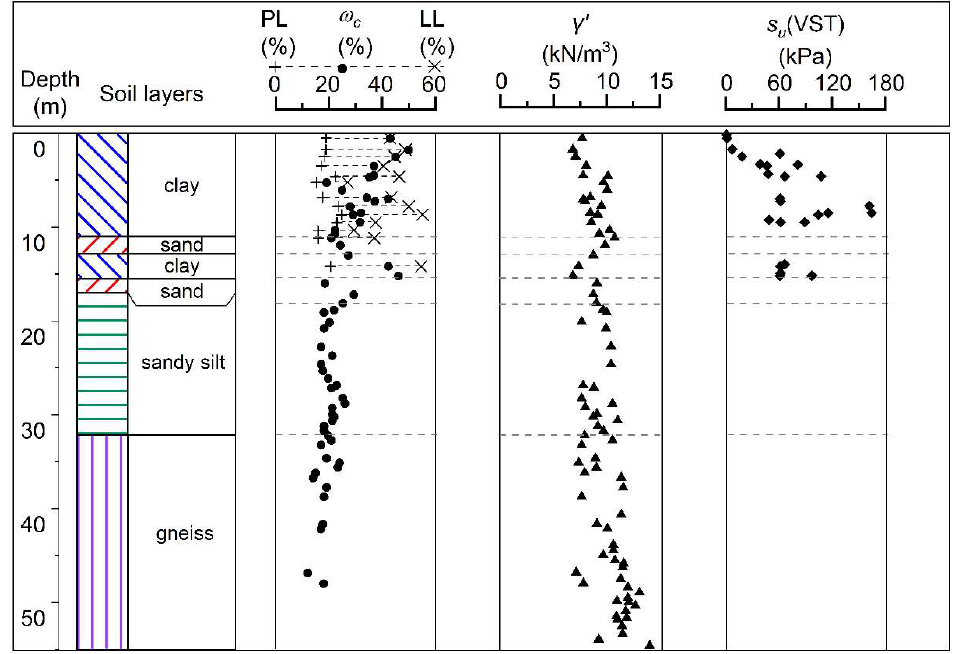
Figure 2. Soil properties. Figure 2. Soil